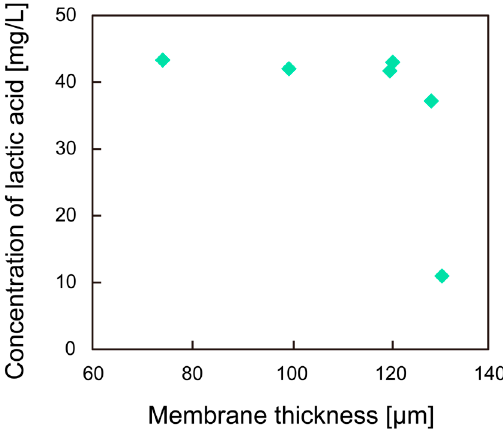
Figure 7. Concentration of the lactic acid produced by C. glutamicum as a function of the membrane thickness of the microfiber.